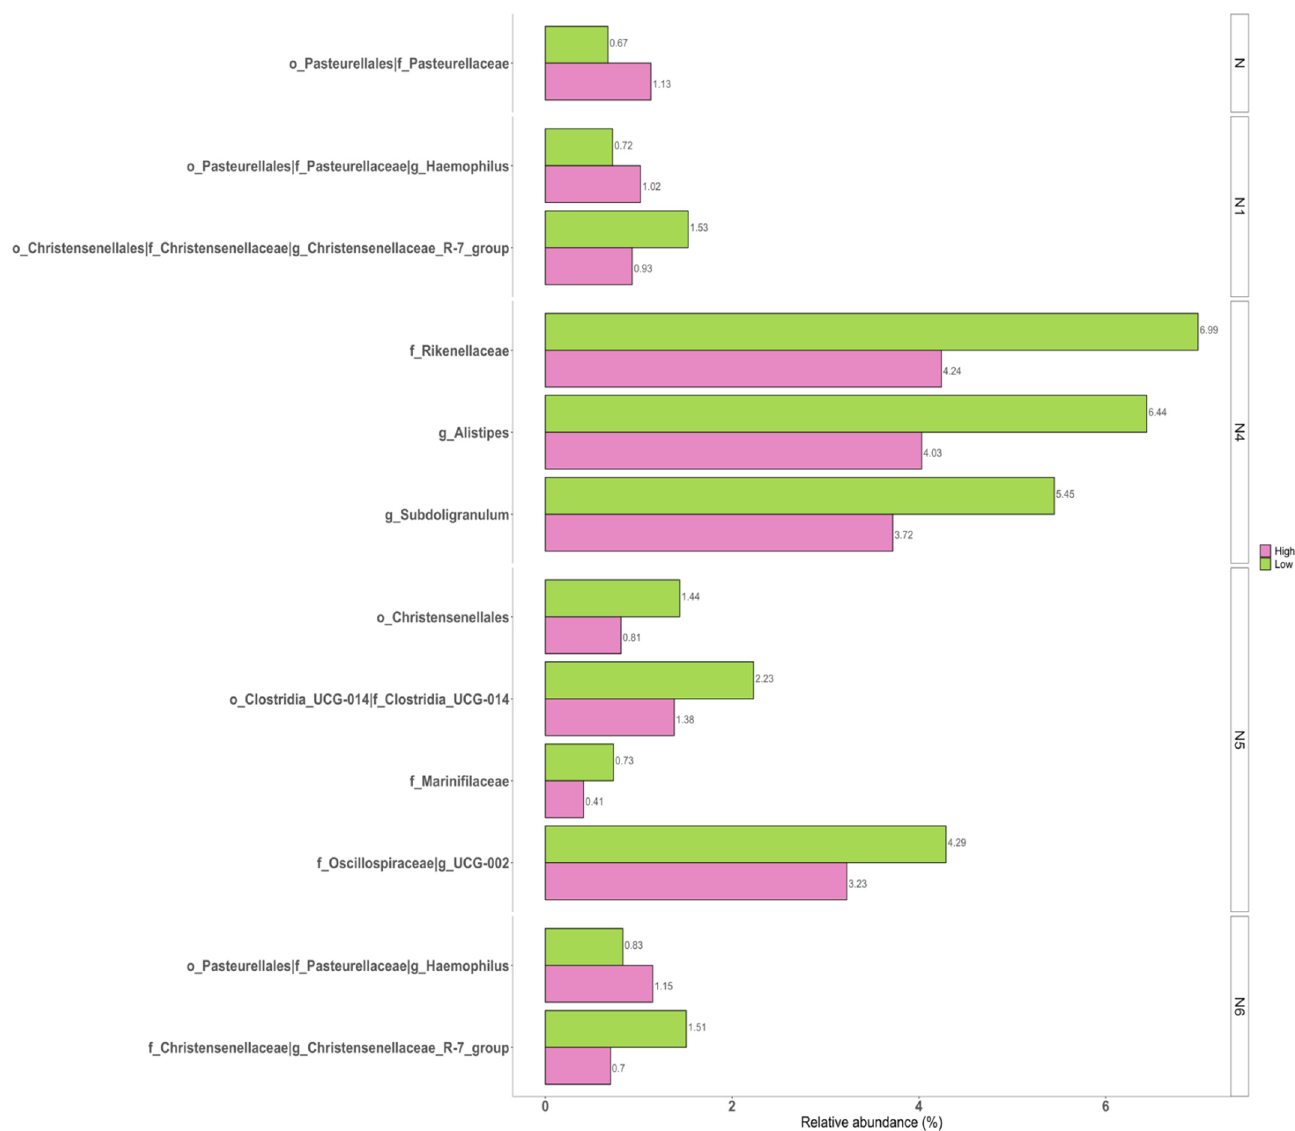
Figure 4. Bar plots for relative abundance of the significant taxa in low and high groups of neuroticism sub-facets. The x -axis shows the mean proportion of the significantly different taxa between the low and high groups. The taxa showed the same relative abundance at every level.